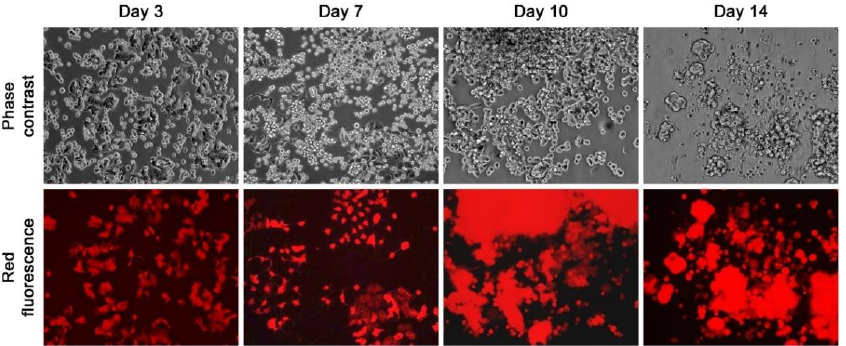
Figure 2. RMCF7-2 morphology and growth behavior during co-culture with HCs. A representative co-culture with Patient #2’s PBMCs demonstrates the gradual changes in the red fluorescent RMCF7-2 cells from Day 3 to Day 14. All the images are shown at 100 × magnification.